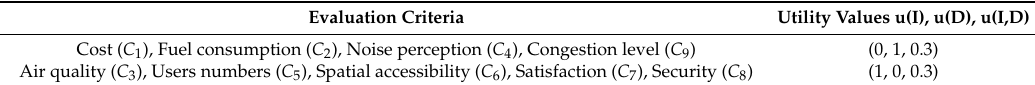
Table 3. Utility values for criteria